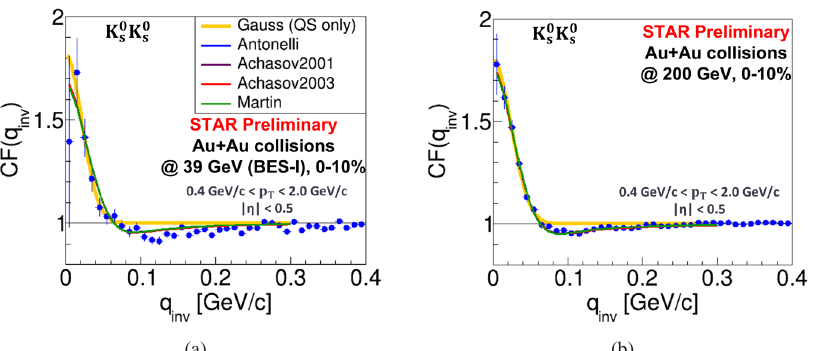
Lednicky-Lyuboshitz parameterizations. Only statistical uncertainties are shown.